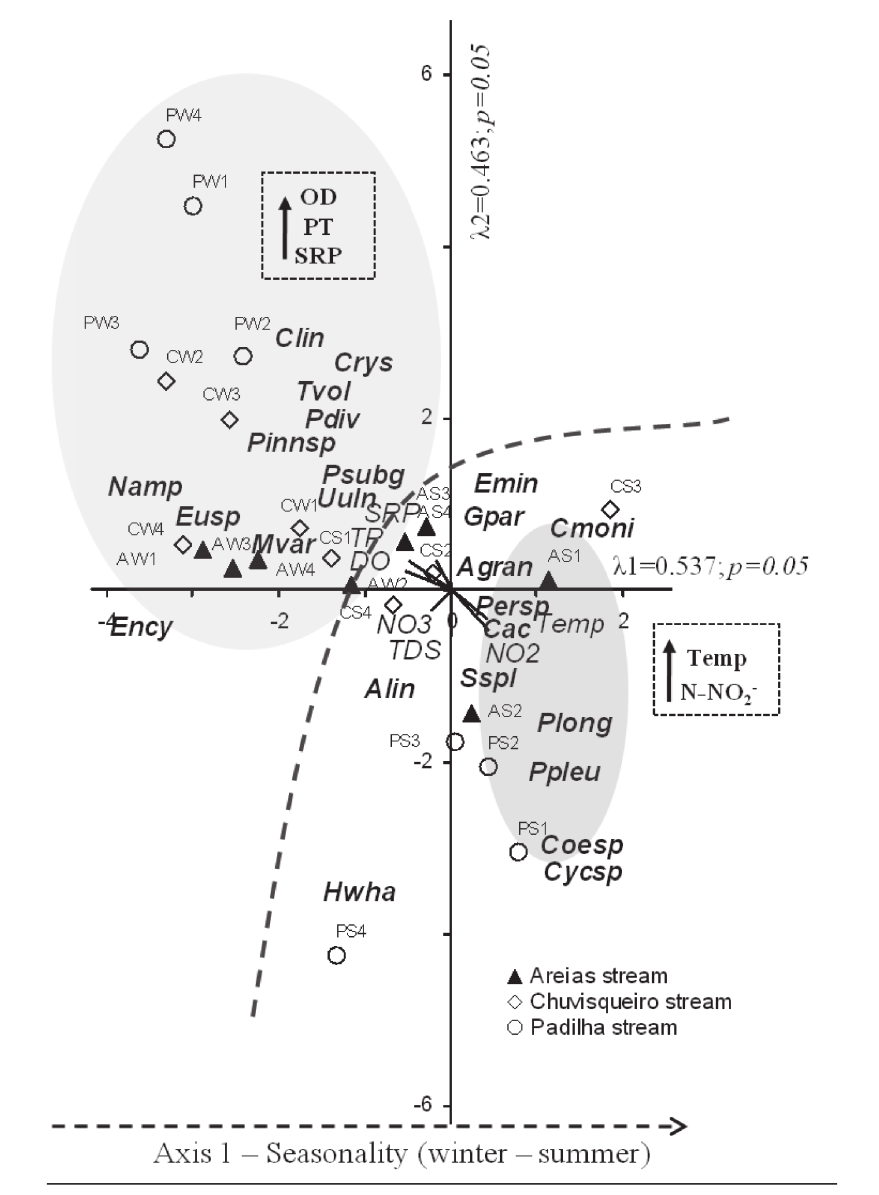
Figure 3 - Ordination by CCA (axis 1 and 2) of the sampled areas in terms of environmental and biological variables (species - biomass (mm 3 .L -1 ). A = Areias stream, C = Chuvisqueiro stream, P = Padilha stream , W = winter, S = summer; 1, 2, 3, 4 = sampled areas. Alin= Amphipleura lindhiemeri ; Agran = Aulacoseira granulata ; Cmoni = Closterium moniliferum ; Cac = Cocconeis placentula var. acuta ; Clin = Cocconeis placentula var. lineata ; Coesp = Coenocytis sp.; Crys = Crysococcus sp.; Cycsp = Cyclotella sp.; Emin = Encyonema minutum ; Ency = Encyonema sp. 1; Eusp. = Euglena sp.; Gpar = Gomphonema parvulum ; Hwha = Hydrosera whampoensis ; Mvar = Melosira varians ; Namp = Nitzschia amphibia ; Persp = Peridinium sp.; Plong = Phacus longicauda ; Ppleu= Phacus pleuronectes ; Pdiv = Pinnularia cf. divergens ; Psub = Pinnularia cf. subgibba ; Pinnsp = Pinnularia sp. 1; Sspl = Surirella splendida ; Tvol= Trachelomonas volvocina ; Uuln= Ulnaria ulna